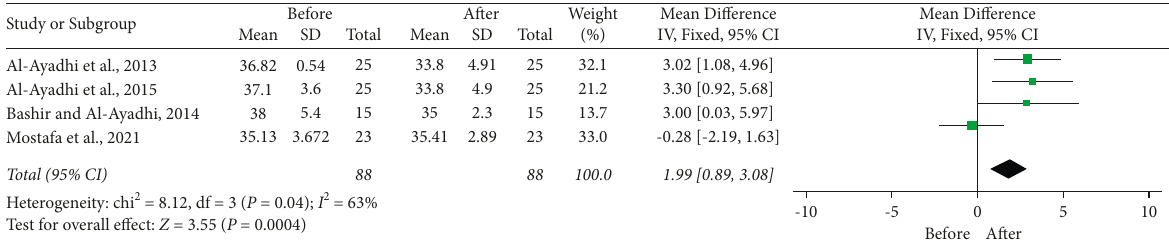
Mean Difference IV, Fixed, 95% CIMean SD